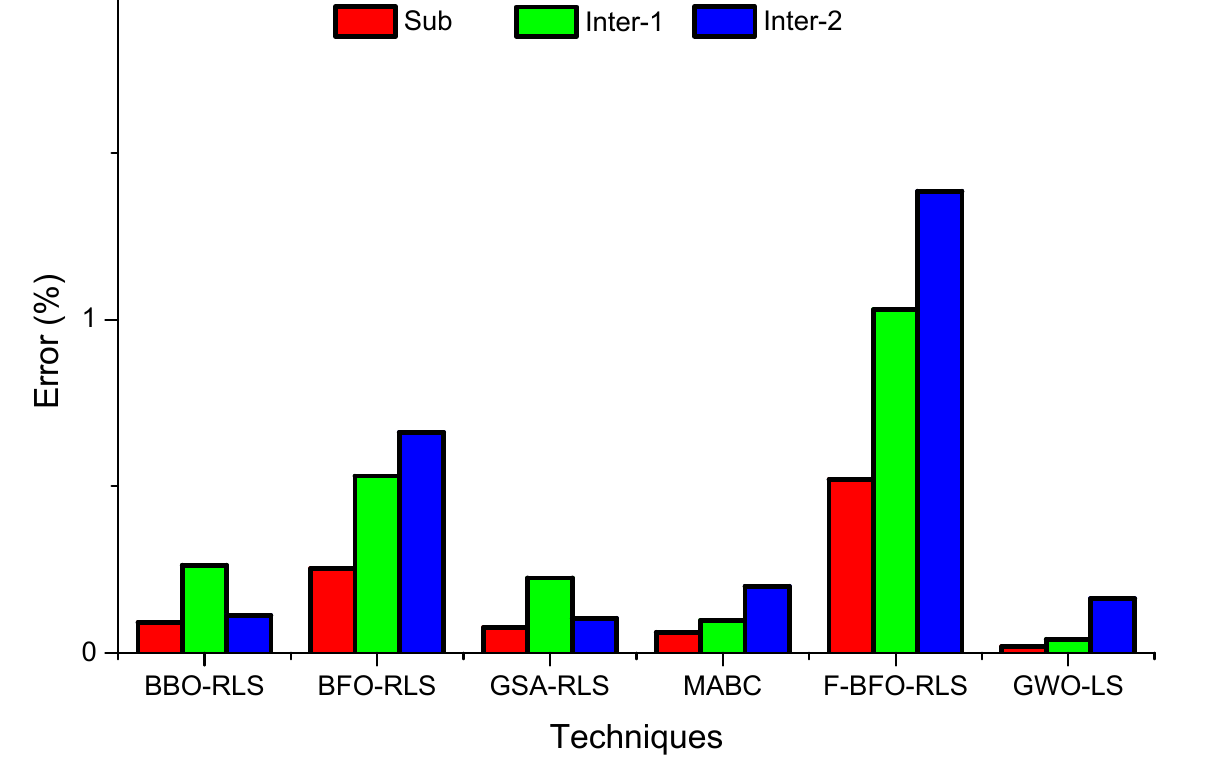
Figure 20. Comparison of phase error for case study-II.